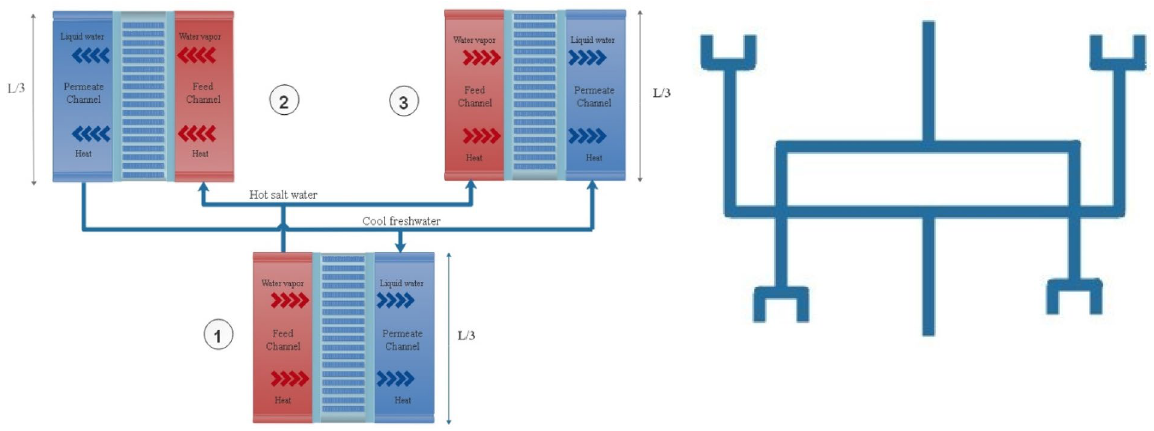
Figure 4. Schematic of constructal DCMD